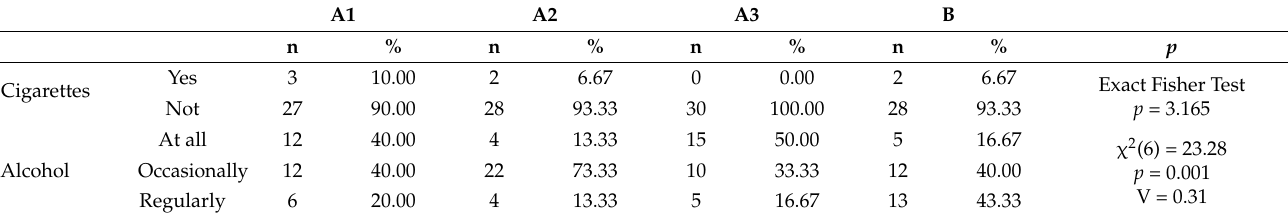
Table 5. Use of stimulants in the study groups and in the control